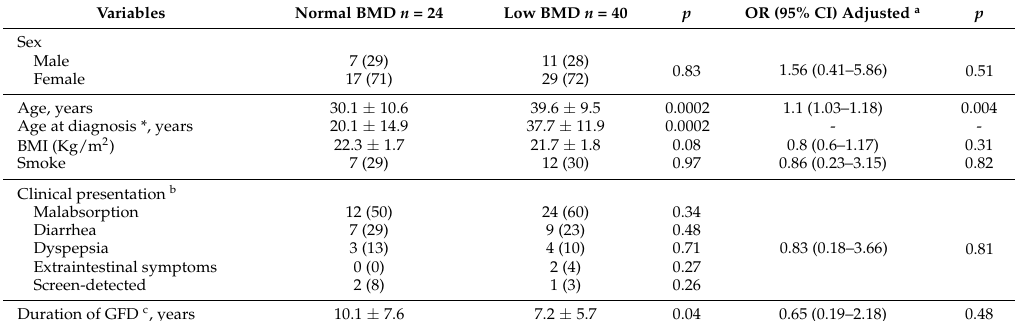
Table 2. Characteristics of the 64 patients with celiac disease on a gluten-free diet according to bone mineral density as assessed by dual energy X ray